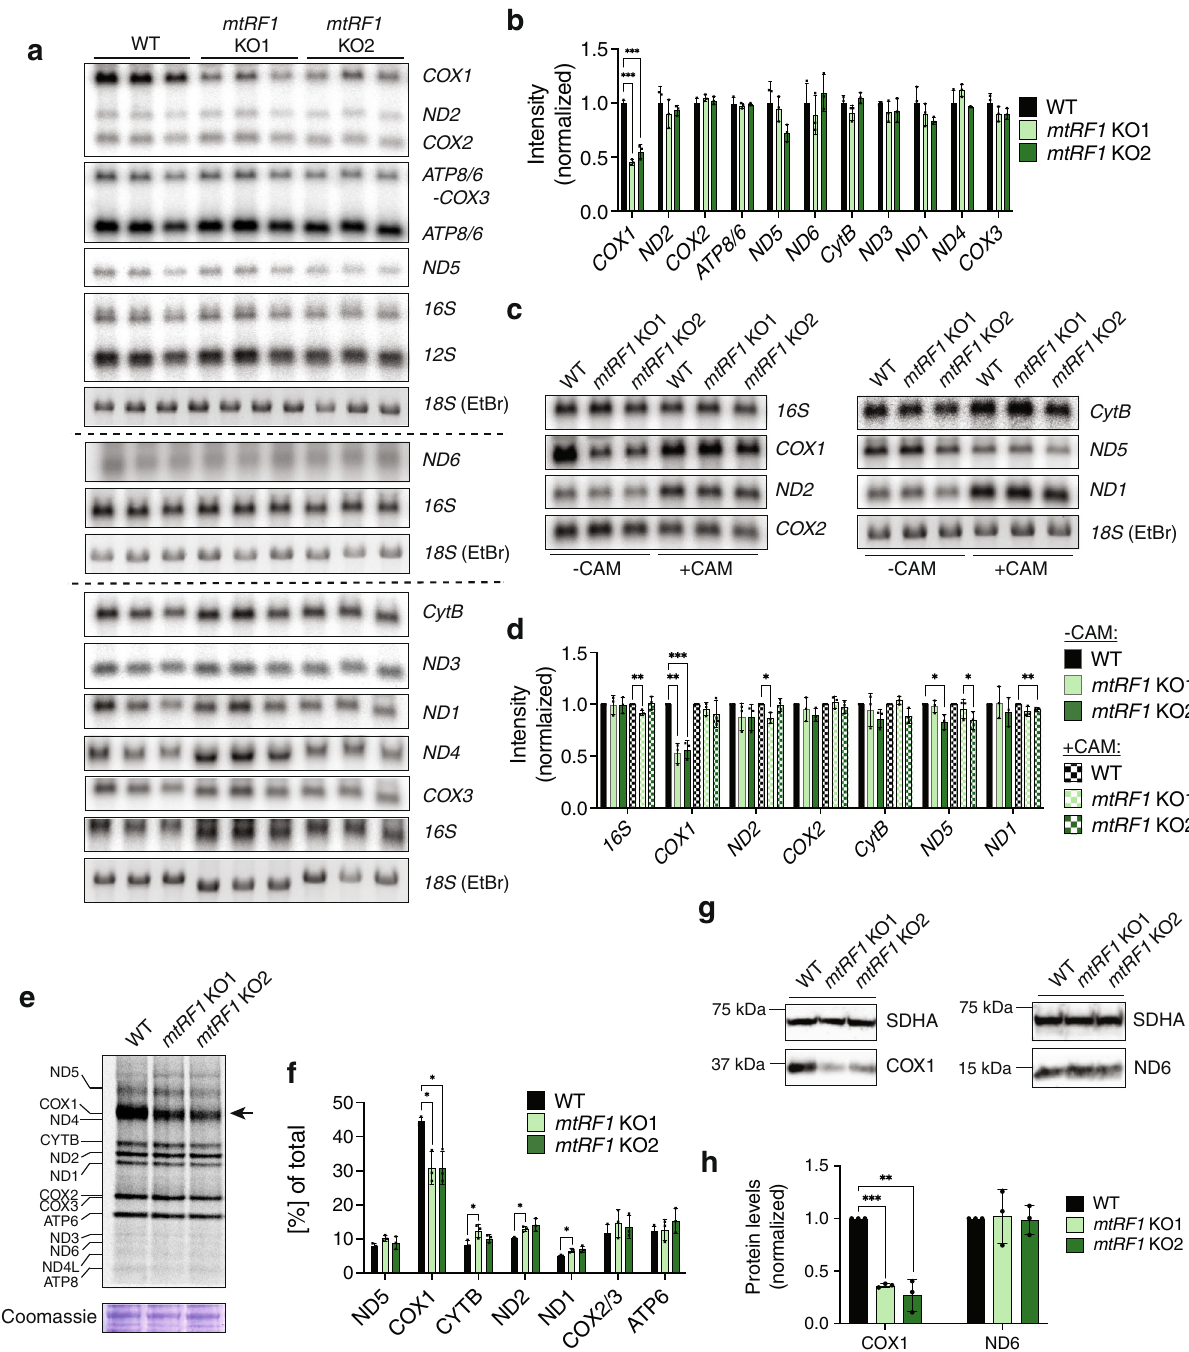
Fig. 2 | Loss of mtRF1 impairs COX1 mRNA and protein levels. a Mitochondrial transcript levels of mtRF1 KO cells compared to WT cells analyzed by northern blotting. Each sample is represented by three biological replicates. Several mem- branes were used to analyze the whole set of mitochondrial transcripts. Separate membranes are indicated by a dotted line. Loading was assessed by ethidium bromide (EtBr) staining of the gel (18S rRNA band) and 16S probing. b Quanti fi cationof a normalized totranscriptlevelsinWTcells.Toaccountforthe differenceinloading,allbandintensitieswere fi rstnormalizedto16Slevels.Means andSDof n =3biologicalreplicates.Unpairedtwo-tailedt-test(* P <0.05;** P <0.01; *** P <0.001). c Effect of chloramphenicol (CAM) treatment on mitochondrial transcript levels of WT and mtRF1 KO cells analyzed by northern blotting. A representativeblotofthreeindependentexperimentsisdepicted. d Quanti fi cation of c normalizedtotranscriptlevelsinWTcells+/ − CAMtreatment,respectively.To